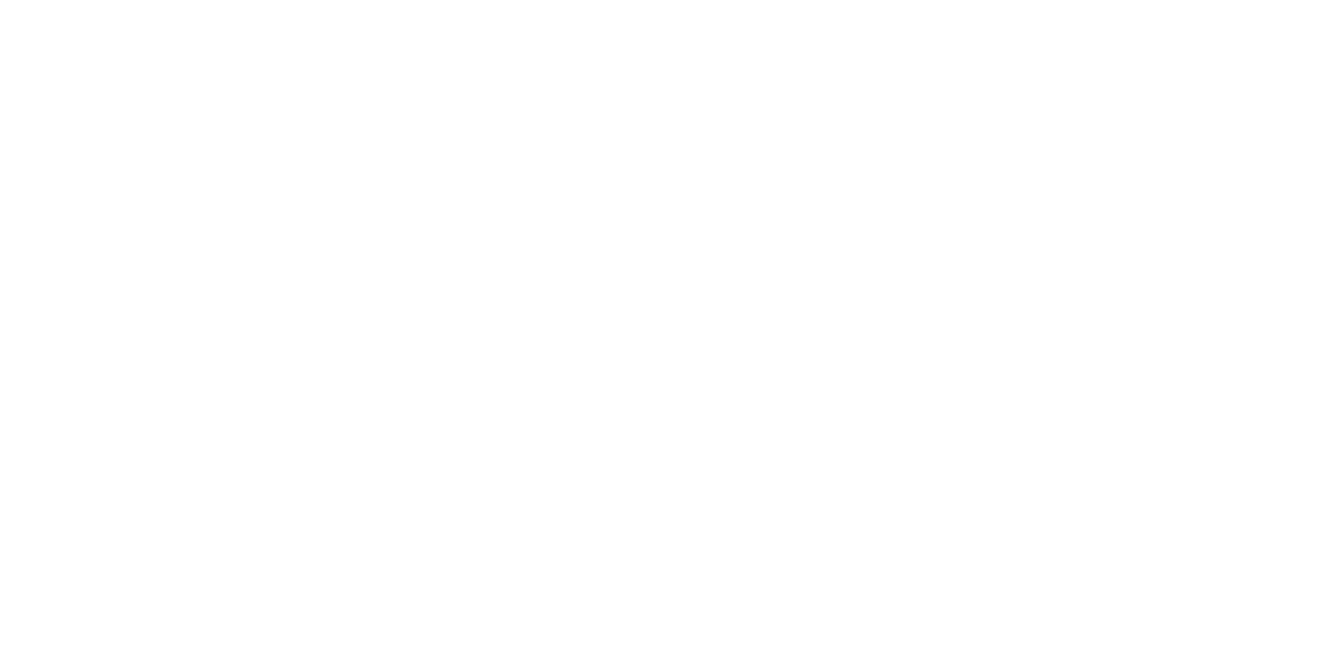
Frontiers in Neurology |